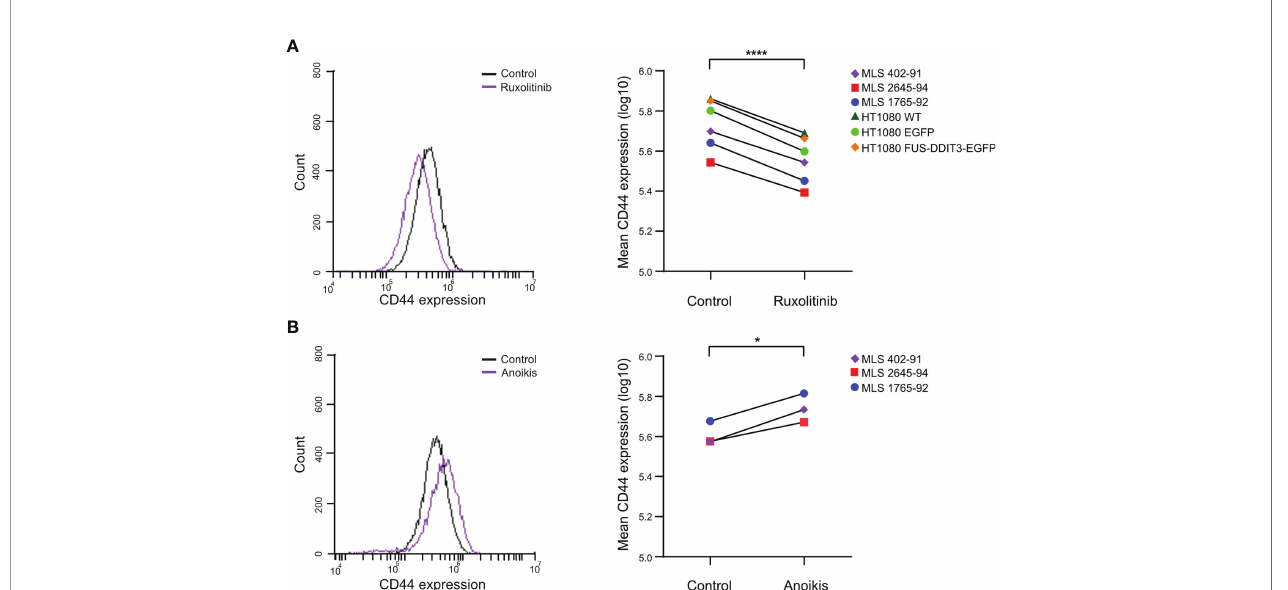
FIGURE 5 | CD44 protein expression analyzed by fl ow cytometry. (A) CD44 regulation by ruxolitinib treatment. The CD44 expression pro fi les of ruxolitinib-treated myxoid liposarcoma (MLS) 402-91 cells compared with control cells treated with DMSO are shown as an example (left panel). Mean CD44 expressions in ruxolitinib- treated MLS (402-91, 2645-94, and 1765-92) and fi brosarcoma [HT1080 wild-type (WT), HT1080 EGFP, and HT1080 FUS-DDIT3-EGFP] cells are shown (right panel). **** p < 0.0001, paired Student ’ s t -test. (B) CD44 regulation by anoikis resistance. The CD44 expression pro fi les of anoikis-resistant MLS 402-91 cells in comparison to control cell cultures in monolayer are shown as example (left panel). Mean CD44 expressions in anoikis-resistant cells compared with control cells for MLS (402-91, 2645-94, and 1765-92) cells are shown (right panel). * p < 0.05, paired Student ’ s t